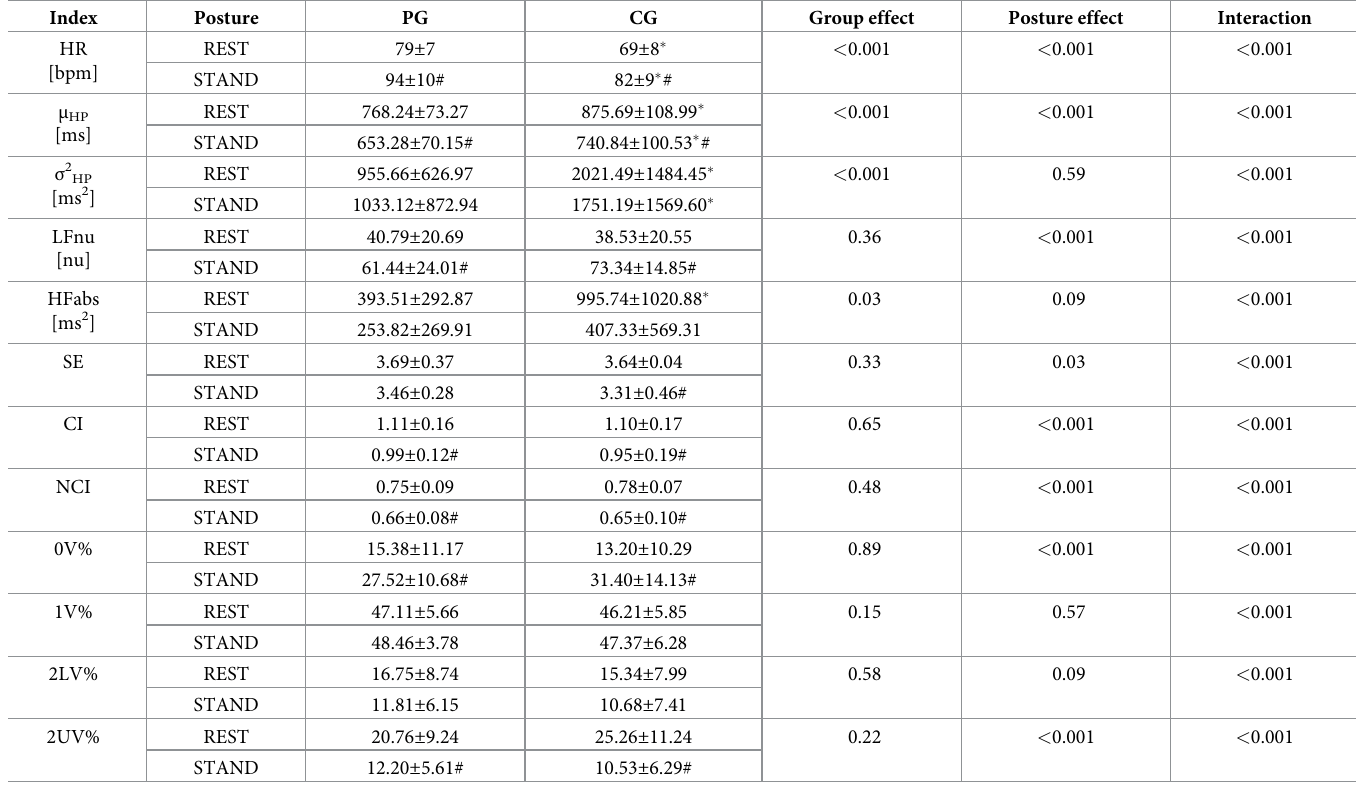
Table 2. HP variability markers assessed in PG and CG via time, frequency, information and symbolic